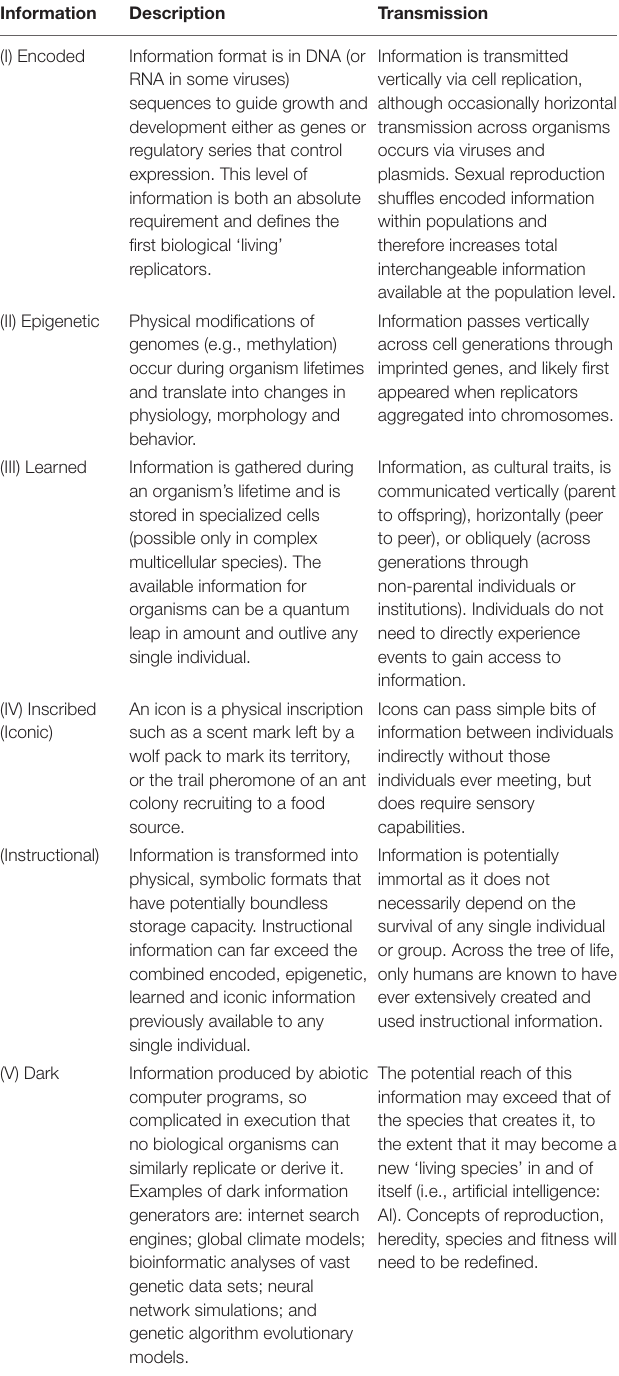
TABLE 2 | The five levels of